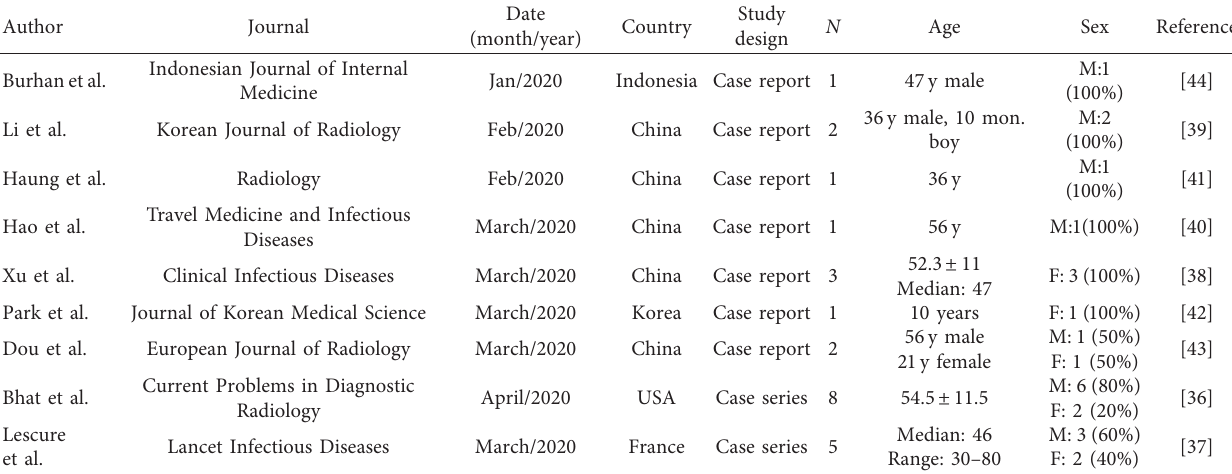
Table 2: Characteristics of the included case reports and case